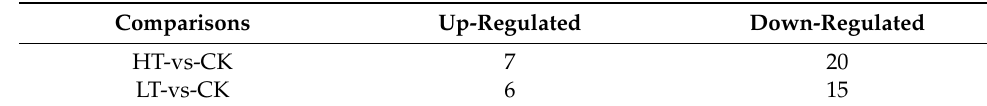
Figure 4. PCA and PERMANOVA of the metabolome of corals under different temperature stresses.